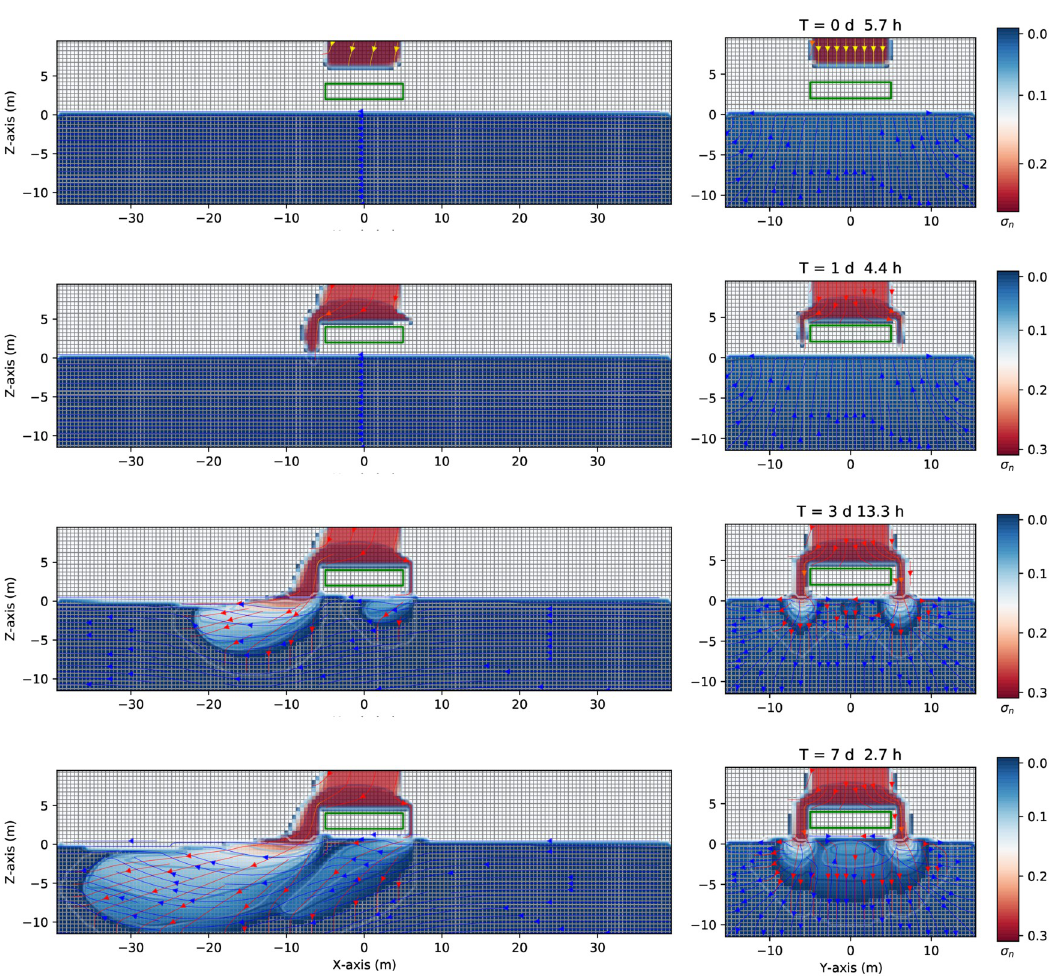
Fig 14. Saturation contours of DNAPL (with a smaller impermeable lens) at different times. Three-dimensional numerical simulation results of the saturation contours ( σ = S ) of a three-phase immiscible fluid flow (water + a continuous source of n n ϕ DNAPL + air) using a spatial grid resolution of 0.50 m and a grid dimension of 80 m × 32 m × 22 m , at different times (plane x = 0). The continuous source of DNAPL encounters an impermeable obstacle (depicted in green), smaller than the one in Fig 12, situated at z = [2.0,4.0] m , x = [ − 5.0, +5.0] m , y = [ − 5.0, +5.0] m . After arriving at the groundwater table, the continuous source of DNAPL keeps going downward and moving to the left direction on both